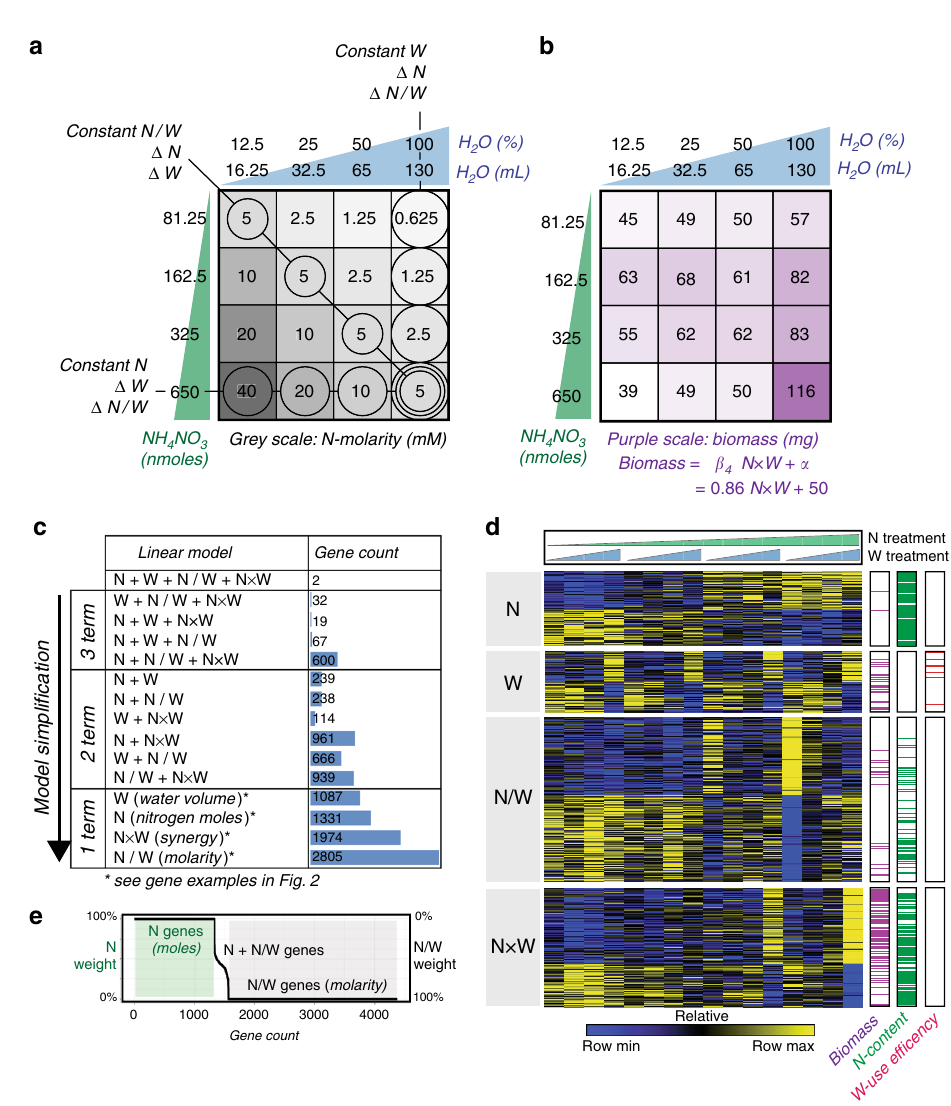
Fig. 1 A factorial design uncovers plant responses to nitrogen and water dose combinations. a A 4-by-4 factorial matrix that varies both N -moles and W -volume can distinguish rice responses to N -moles, W -volume, and N -molarity. b A synergistic effect between N -moles and W -volume, modeled by the N × W interaction term, best explains changes in shoot biomass (linear model, p = 1.3 × 10 − 5 ). c Through model simpli fi cation, 14 linear models uncover genome-wide responses to N -moles, W -volume, N / W (molarity), N × W , and their combinations (linear model, adj. p < 0.005). d Expression heatmap of genes fi tted by a single model term, and the proportion of genes within each class that signi fi cantly correlated with biomass, leaf N-content, and leaf W-use ef fi ciency (Pearson correlation, adj. p < 0.05). e By comparing the normalized coef fi cients of genes fi t by N , N / W , and N + N / W linear models, we found that genes were regulated exclusively in response to changes in N -moles (1331 genes) or N -molarity (2805 genes), while only 238 genes responded to a combination of changes in both N -moles and N -molarity. Source data for d are provided in Source Data fi